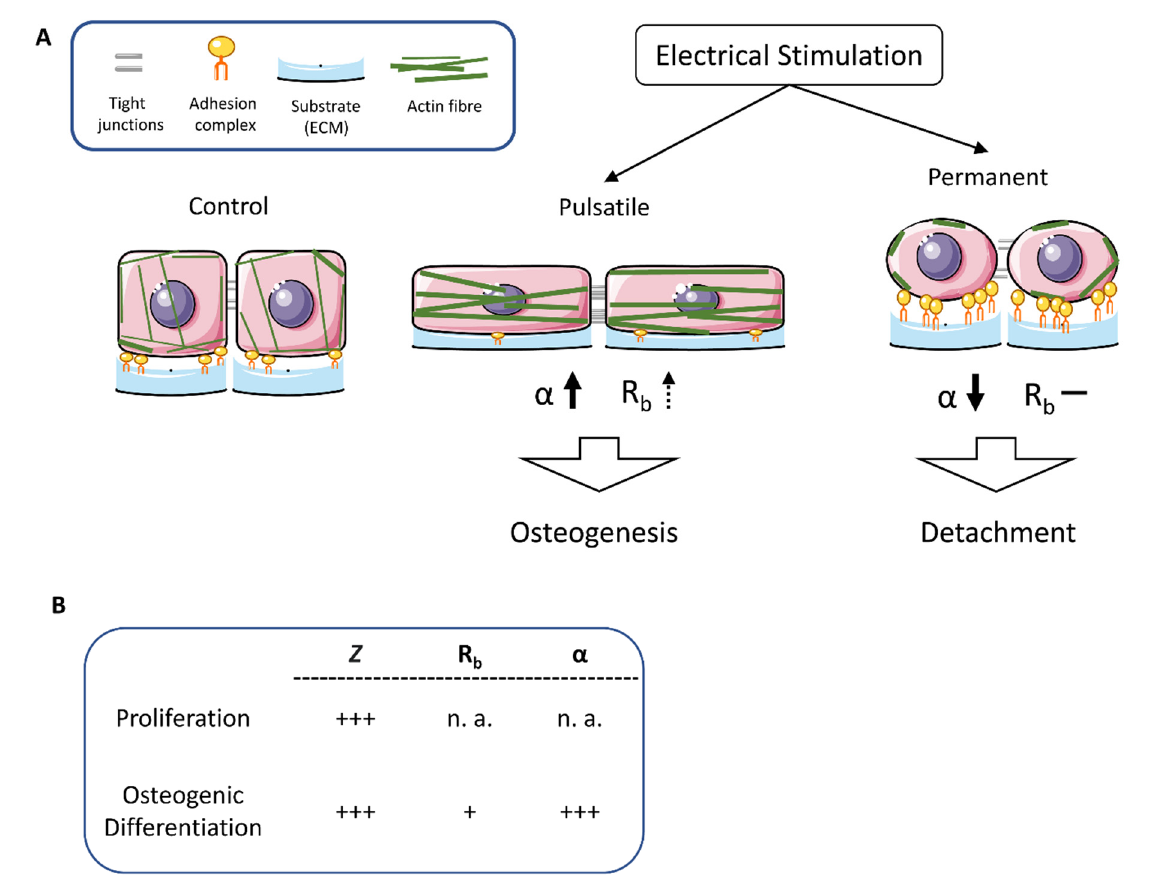
Figure 7. Schematic presentation of morphological alterations after pulsatile and continuous electrical stimulation. ( A ) Pulsatile stimulation resulted in decreased space between the cellular membrane and substrate and increased α values. It appears that the cells nestle against the ground, causing the actin cytoskeleton to stiffen and the number of basal adhesion proteins to decrease. In contrast, the continuous stimulation causes the cells to round up, accompanied by increased expression of the adhesion molecules in the periphery to prevent the cells from detaching. The actin fibers mainly localize to the cell periphery. ( B ) Summary of the alterations of impedance (Z), resistance (R b ), and cleft impedance ( α ) in comparison of proliferating and osteogenic differentiating stem cells. + low increase, +++ significant increase, n. a. no alterations.